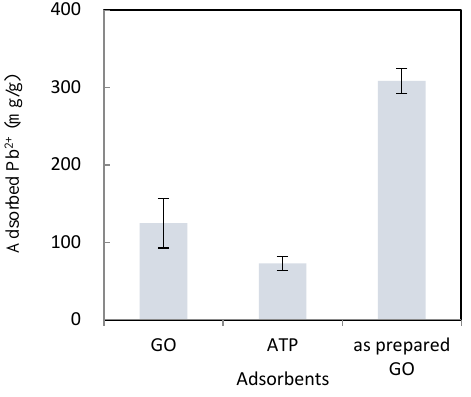
Figure 5. Removal efficiencies of GO, ATP, and as-prepared GO.